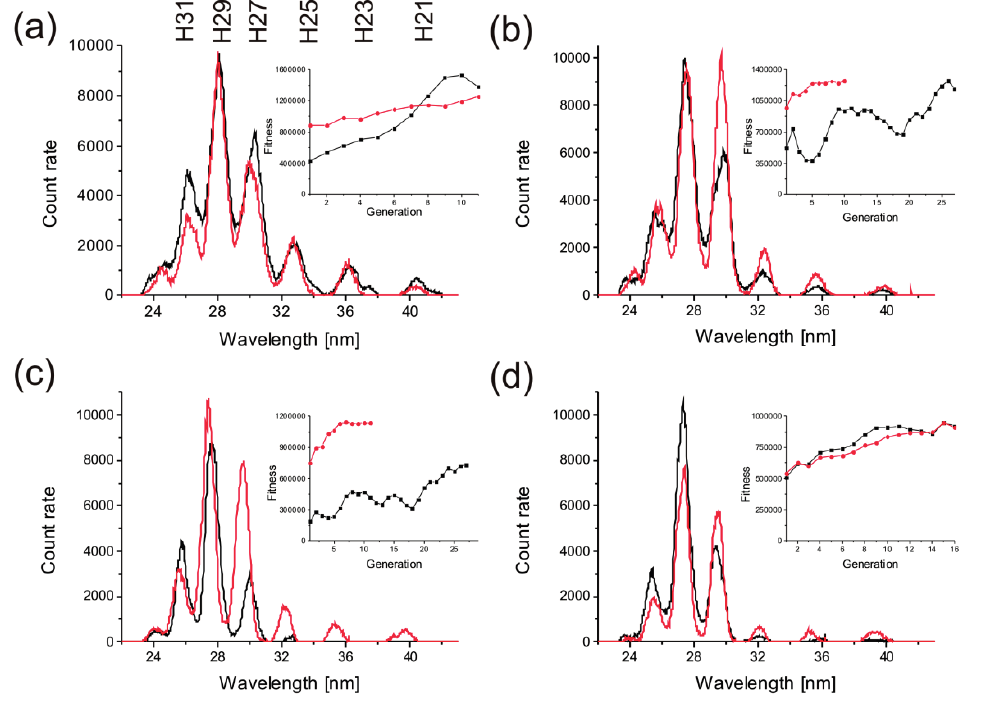
Figure 6. Optimized high-harmonic spectra from an argon-filled HCF are shown for temporally shaped pulses after spectral broadening in argon (black curve) and SF 6 (red curve). The optimization was performed to achieve the maximum yield between 23 and 43 nm and the fitness of the fittest individual of each generation is shown in the inset. The optimizations were performed at ( a ) 10 mbar; ( b ) 20 mbar; ( c ) 30 mbar and ( d ) 40 mbar argon backing pressure in the high-harmonic generation